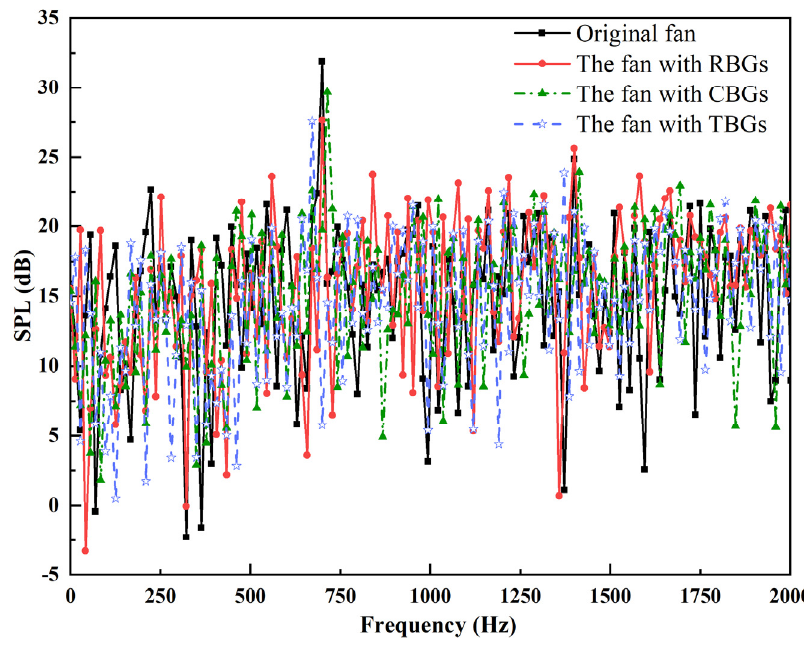
Figure 17. Comparison of SPL spectrum between original fan and that with bionic groove.